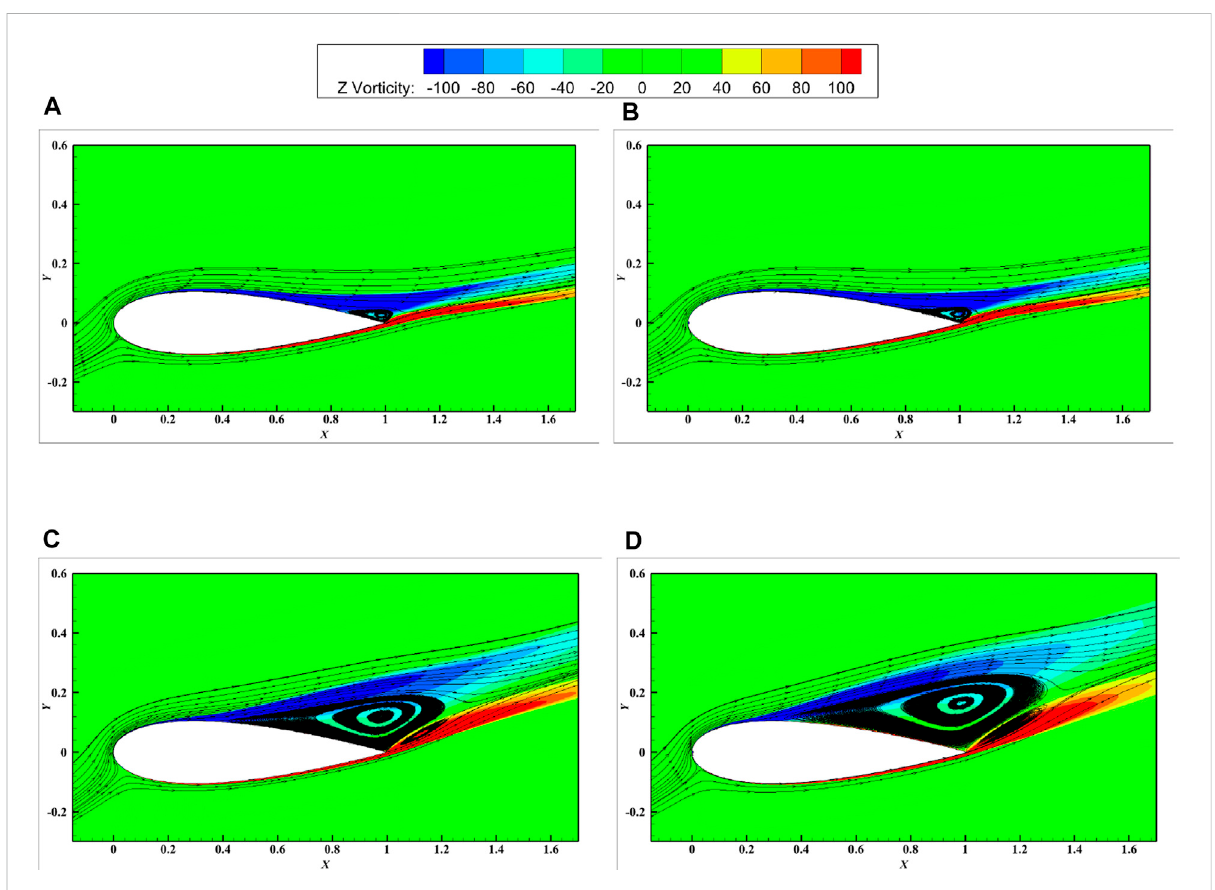
FIGURE 12 SchematicdiagramofthesurfacestreamlineandvorticityoftheNACA0021primitiveandsemi-circularleadingedgeerosionairfoil( h 1 =0.5% c ).